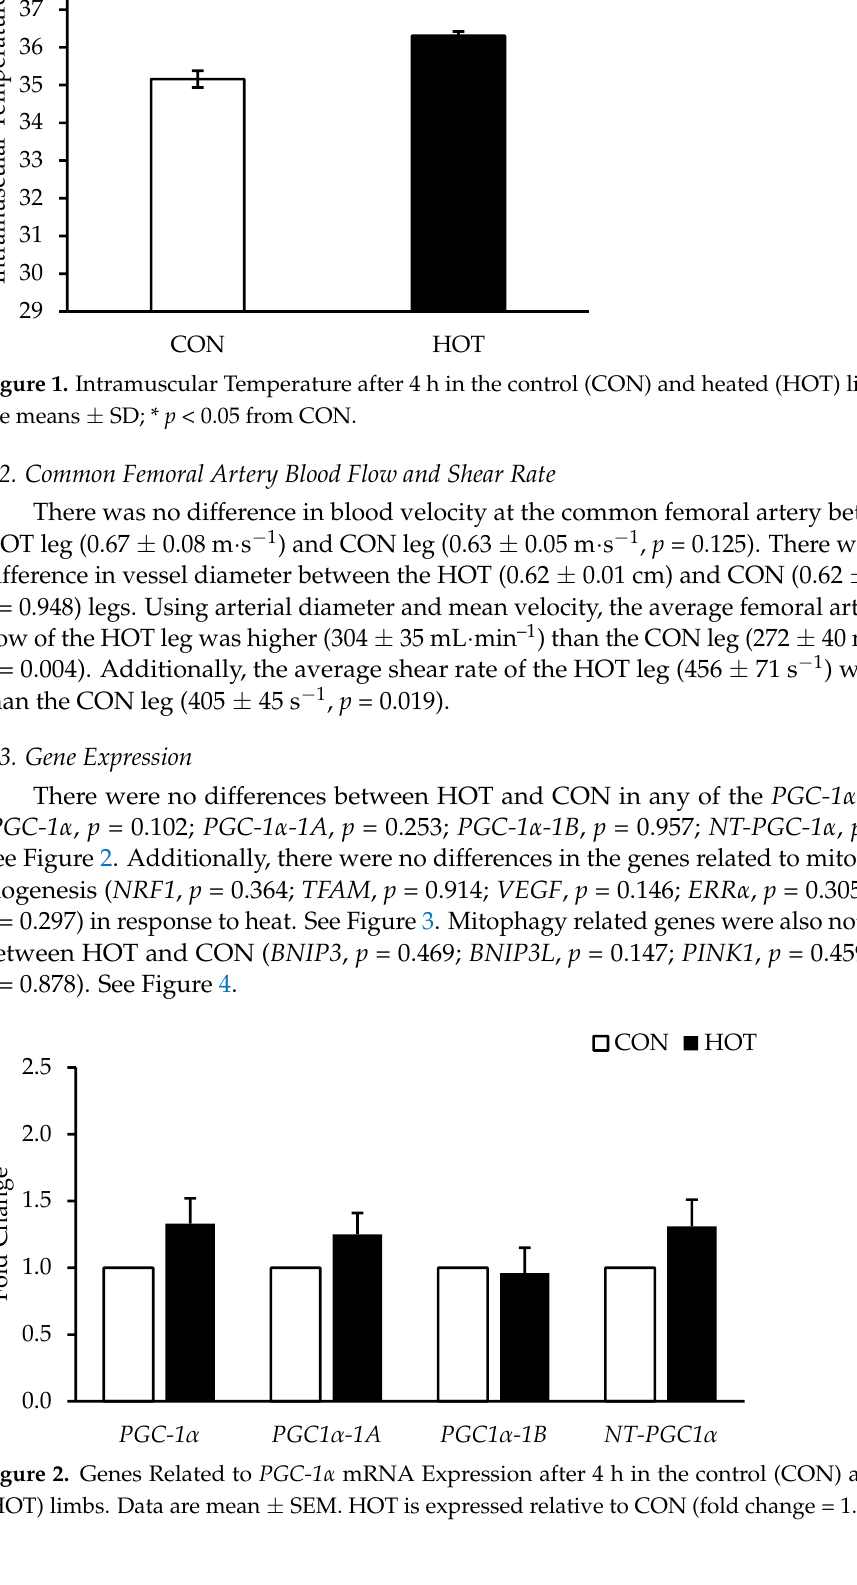
Figure 3. Genes Related to Mitochondrial Biogenesis mRNA Expression after 4 h in the control (CON) and heated (HOT) limbs. Data are mean ± SE. HOT is expressed relative to CON (fold change = 1.0). Figure 4. Genes Related to Mitophagy mRNA Expression after 4 h in the control (CON) and heated (HOT) limbs. Data are mean ± SE. HOT is expressed relative to CON (fold change = 1.0).